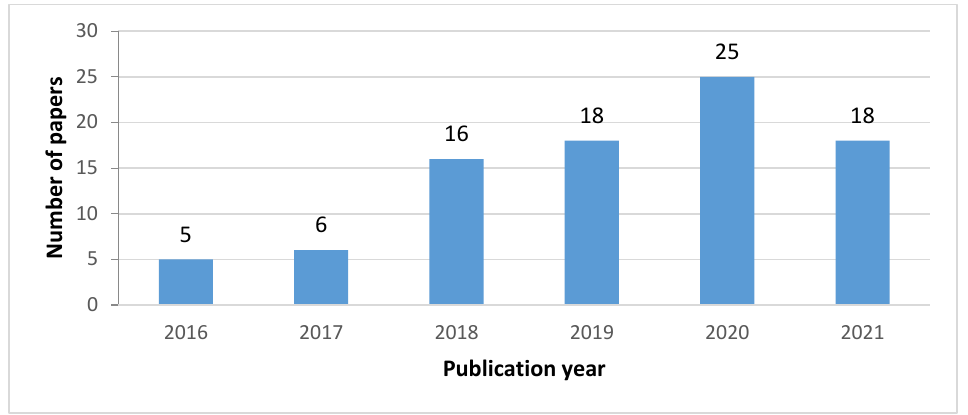
Figure 1. Distribution of the extracted papers by publication year.